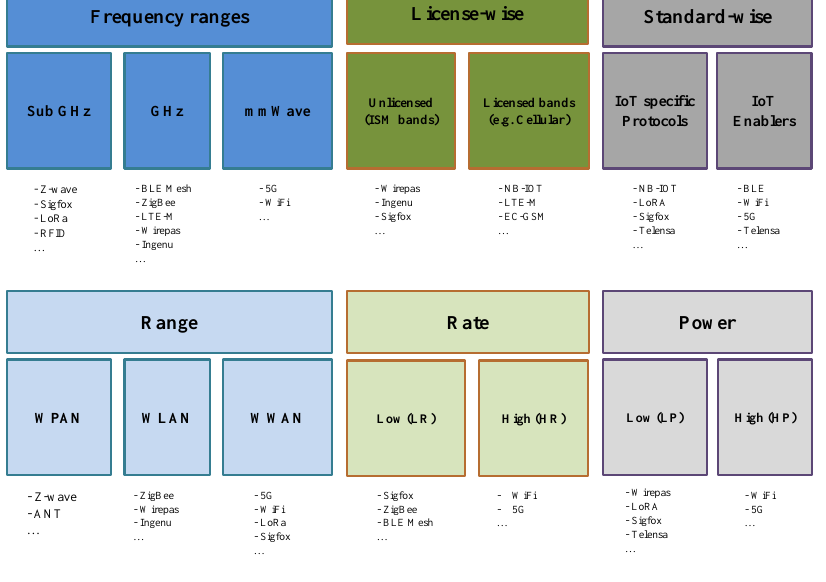
Figure 4. Classification of IoT